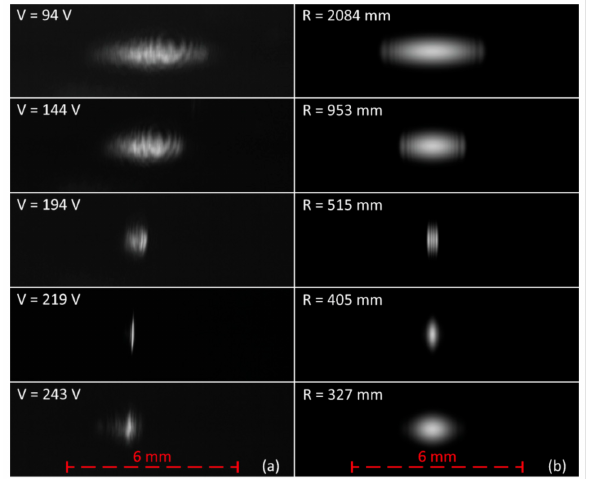
Figure 12. Comparison of measured ( a ) and simulated ( b ) beam profiles for varying MAAM mirror radii. For the measured beam profiles, the corresponding membrane voltages are shown in the images. For the simulated beam profiles, the mirror radii used in the simulations are shown. Note the additional simulated beam profile for the interpolated mirror radius of R = 460 mm in Figure 13, which exhibts a similar beam width like the measurement at 219 V. All images are normalized to an image gray value of 200 for the measured or simulated peak irradiance.